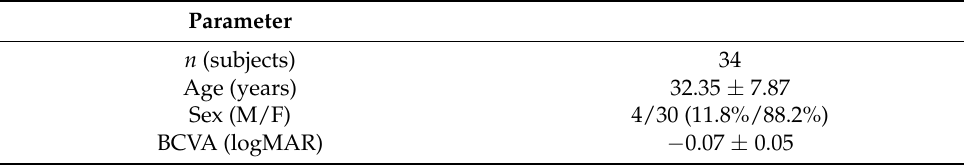
Table 1. Demographic and clinical data of the enrolled participants. Parameter n (subjects) 34 Age (years) 32.35 ± 7.87 Sex (M/F) 4/30 (11.8%/88.2%)